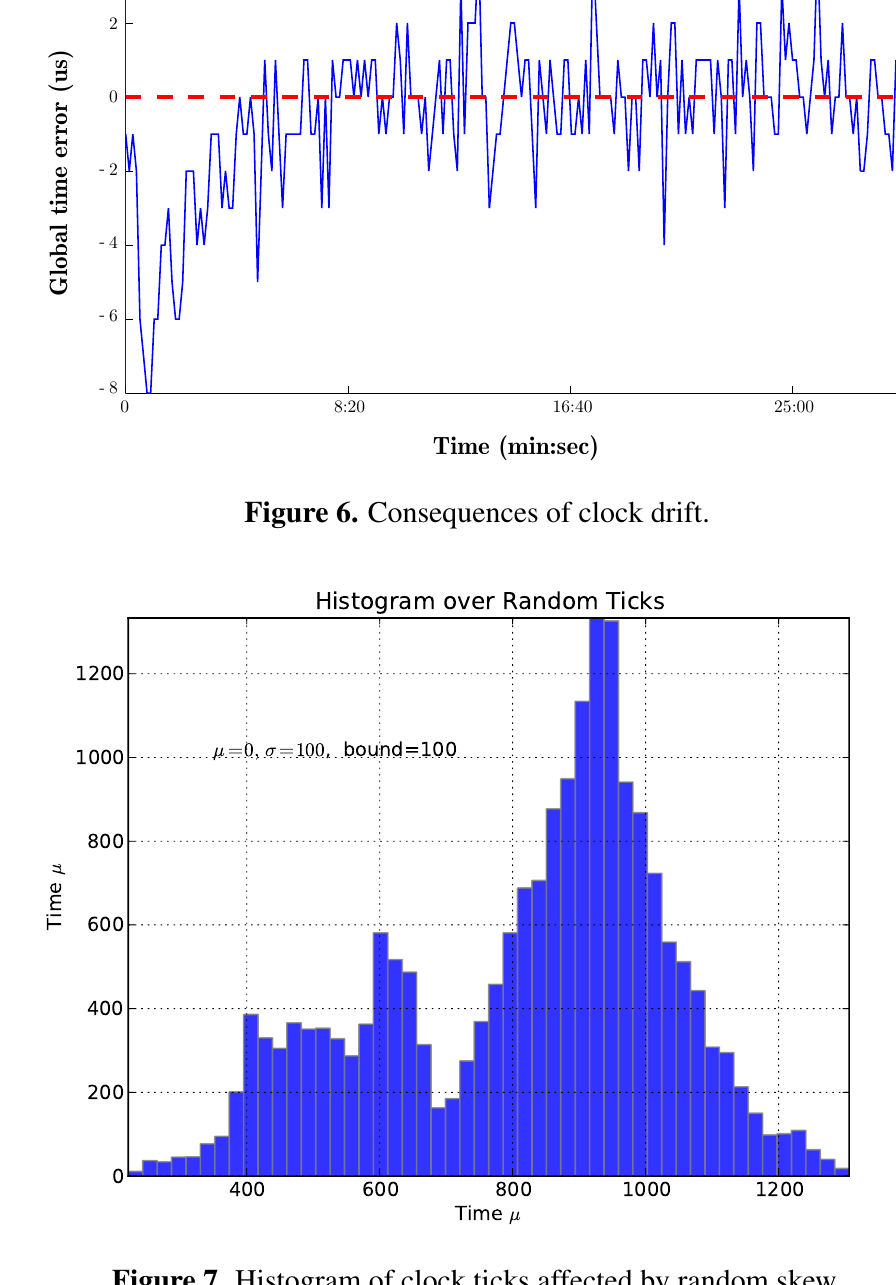
Figure 7. Histogram of clock ticks affected by random